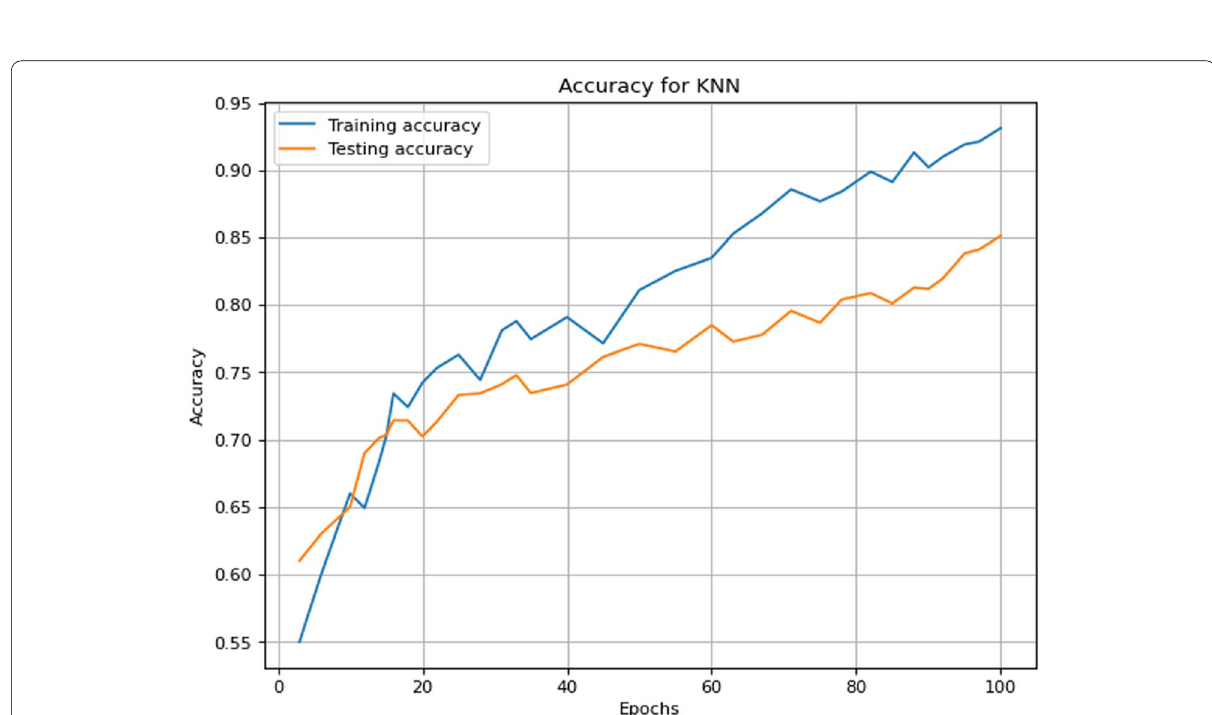
Fig. 21 Accuracy for our proposed model with